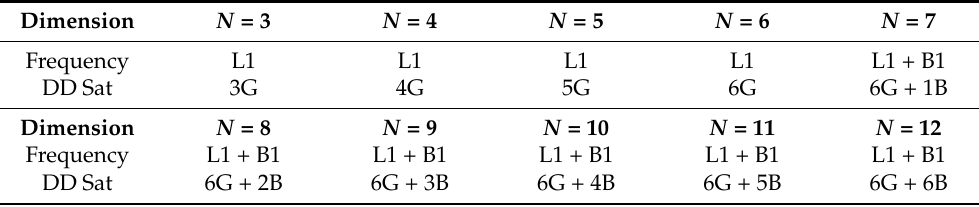
Table 3. Frequency and satellite information with various DD ambiguity